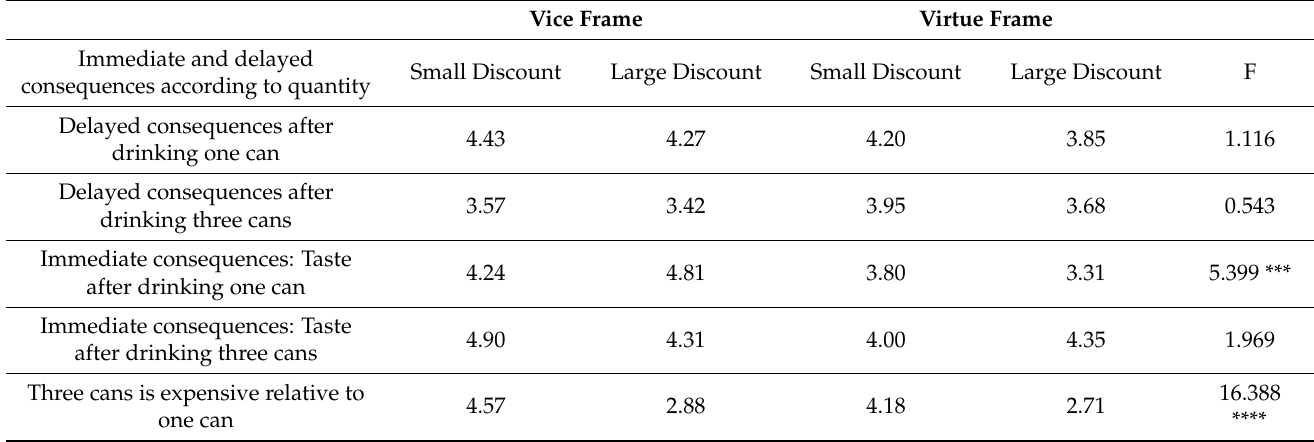
Table 3. Average values of the control variables (N = 176). Vice Frame Virtue